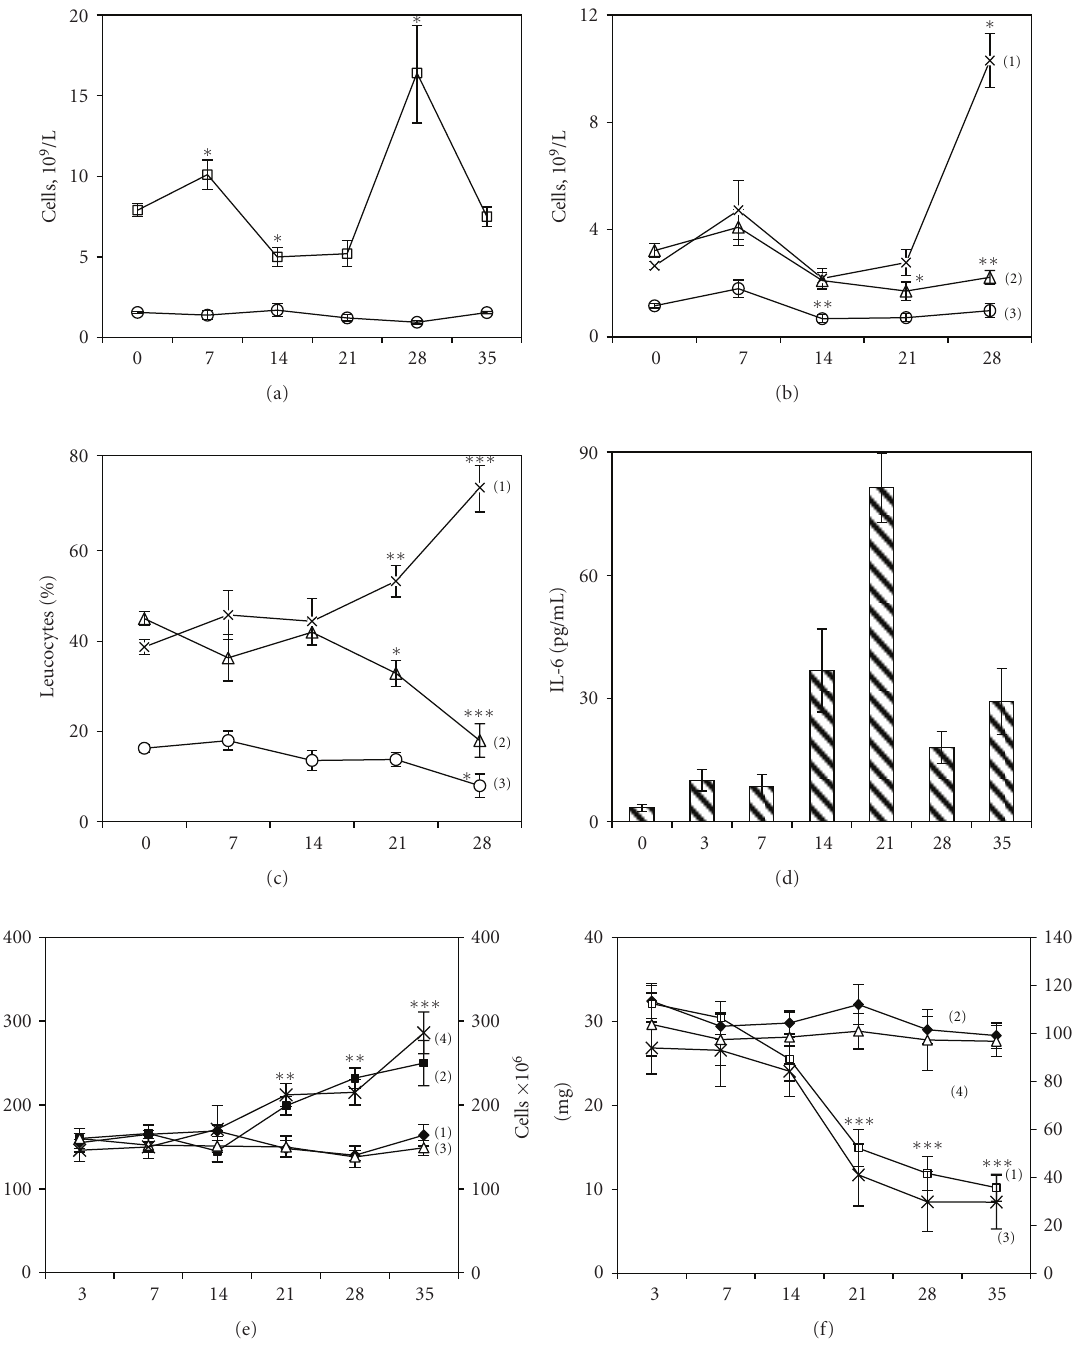
Figure 7: The influence of tumor growth on blood leukocytes, cytokine serum level, spleen, and thymus. (a)—blood leukocyte (upper curve) and peritoneal cell (lower curve) counts during the growth of hepatoma 22a. (b)—absolute cell numbers of leukocytes in the blood of tumor-bearing mice: polymorphonucleus leukocytes (1), lymphocytes (2), and monocytes (3). (c)—percent of total number of leukocytes: polymorphonucleus leukocytes (1), lymphocytes (2), and monocytes (3). Each point represents average values of 10 mice (M ± SEM), ∗ P < . 05, ∗∗ P < . 01, ∗∗∗ P < . 001 compared to control. (d)—serum IL-6 level determined by ELISA, pg/mL. Each bar represents average values of 5 mice (M ± SEM). At every timepoint the data were compared to appropriate control group of mice. In (a)—(d) all data from control mice were combined into groups shown on day 0 (M ± SEM). (e)—spleen weight, mg (2: tumor-bearers, 3: control mice) and total number of nucleated cells per organ, mln (1: control mice, 4: tumor-bearers). (f)—thymus weight, mg (1: tumor-bearers, 2: control mice), and total number of nucleated cells per organ, mln (3: tumor-bearers, 4: control mice). Each point represents average values of 10 mice (M ±